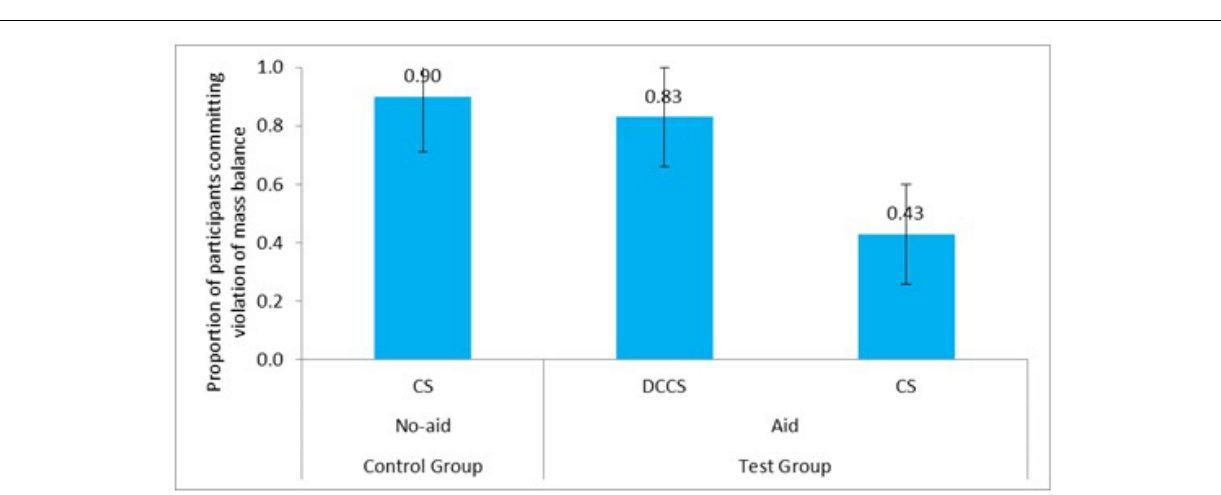
FIGURE 13 | Proportion of participants committing violation of mass balance in the Aid and No-Aid conditions. The error bar represents the 95% confidence interval around the point